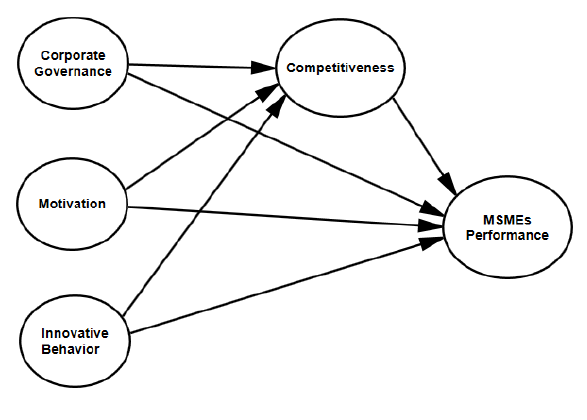
Figure 1 : Conceptual Framework